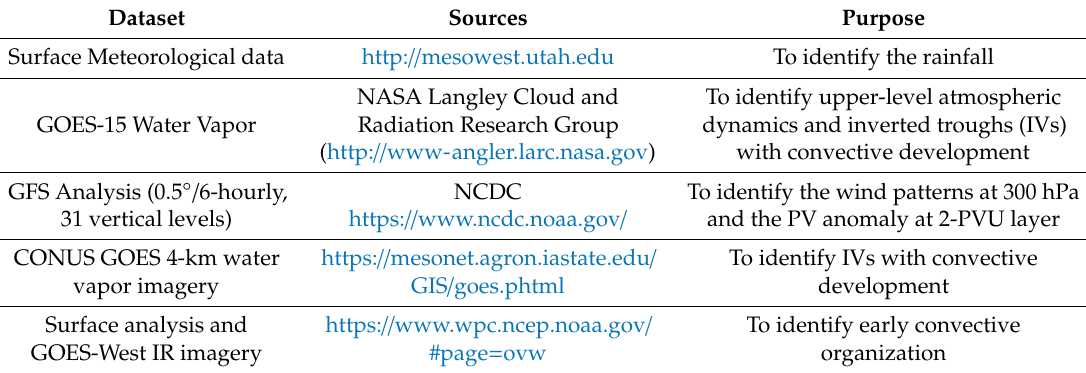
Table 3. Other satellite and model products used for classifying monsoon days.